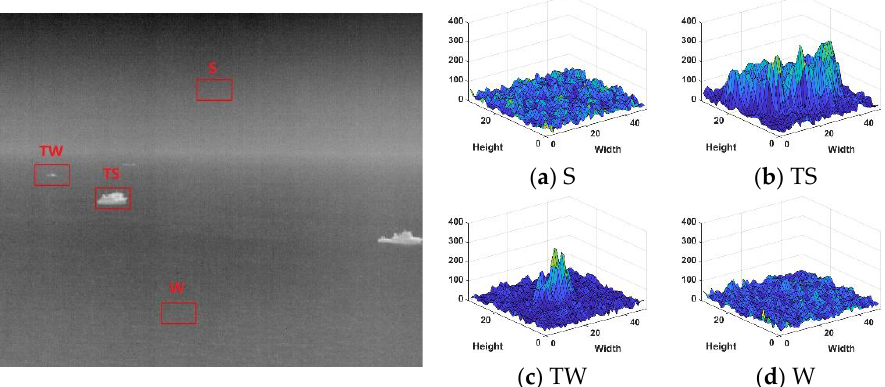
Figure 1. Calm sea image and 3D Fof local gradient magnitude. ( a ) Sky area; ( b ) target with complex contours area; ( c ) dim point target area; ( d ) sea clutter area.